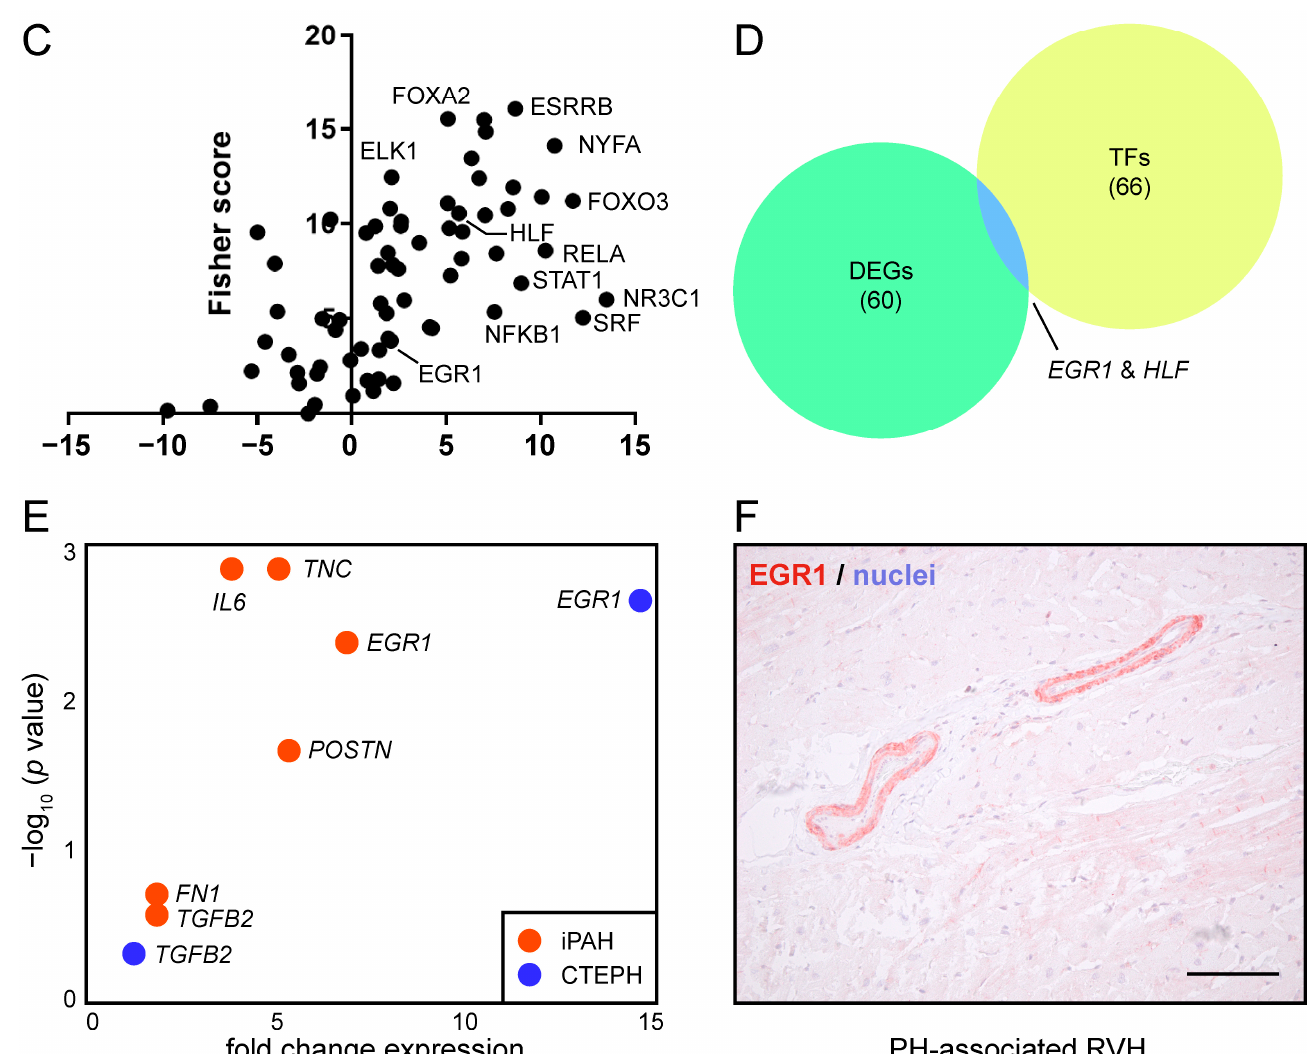
Figure 4. Identification of TFs governing postoperative reverse cardiac remodeling. ( A ) Genes highly expressed preoperatively and downregulated 3 months after surgery were screened for TFBS. Factors identified in ( A ) iPAH and ( C ) CTEPH are depicted as a function of z- and Fisher scores. An area- proportional Venn diagram of overlapping DEGs and TFs identified by TFBS analysis in ( B ) iPAH and ( D ) CTEPH patients. Numbers indicate absolute number of genes. ( E ) Average expression values of EGR1 downstream genes of iPAH and CTEPH patients. Fold-change expression was determined by comparing pre- and postsurgery values. ( F ) Histocytochemistry of EGR1 in the hypertrophic right ventricle of a PH patient. One representative micrograph of n = 3 donors is shown. Scale bar = 100 µ